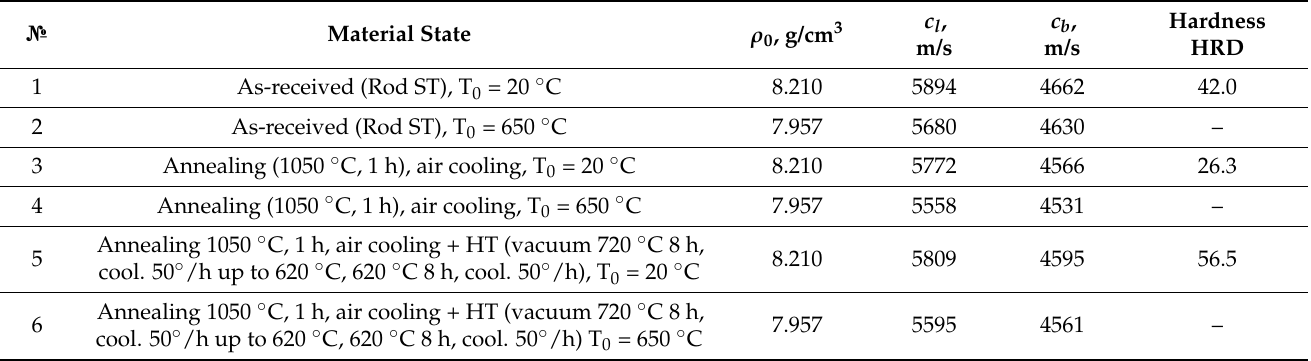
Table 2. Regimes of heat treatment, measured values of density, longitudinal sound velocity and hardness of Inconel 718 alloy, calculated values of bulk sound speed at room and 650 ◦ C temperatures and calculated values of density and longitudinal sound speed at 650 ◦